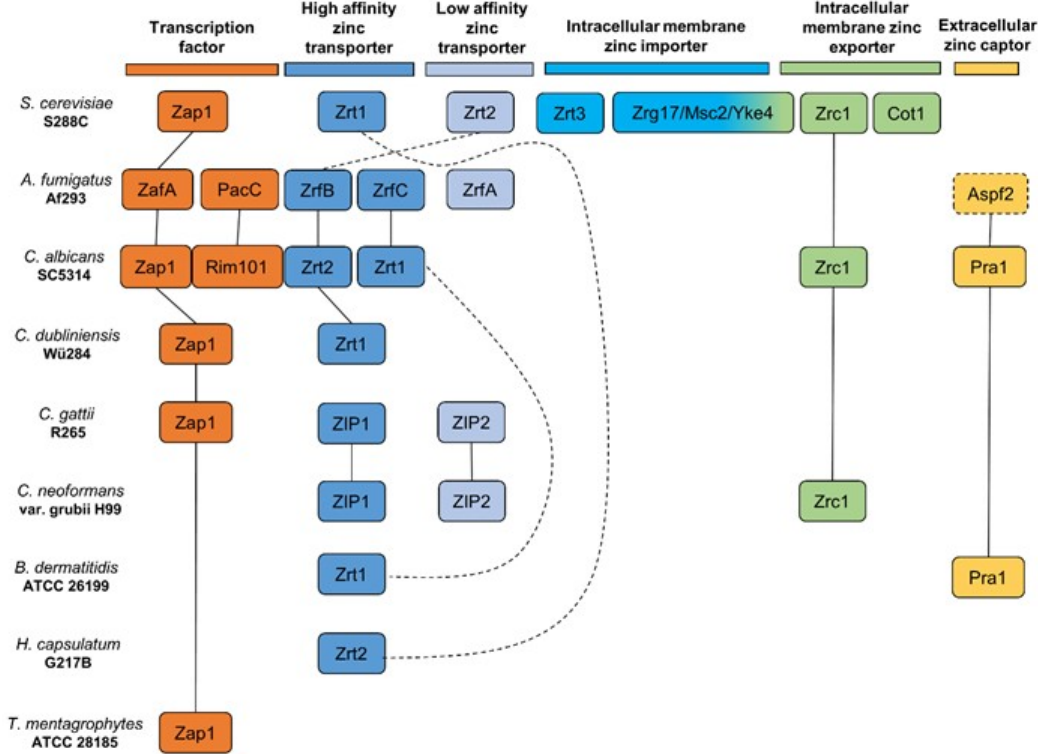
Figure 4. Schematic with all proteins involved in zinc transport, and its regulation, experimentally characterized in pathogenic fungi. Straight lines represent orthologs proven by experimental analysis. Dotted lines represent orthologs consensus based on reviewed studies with pending experimental analysis.